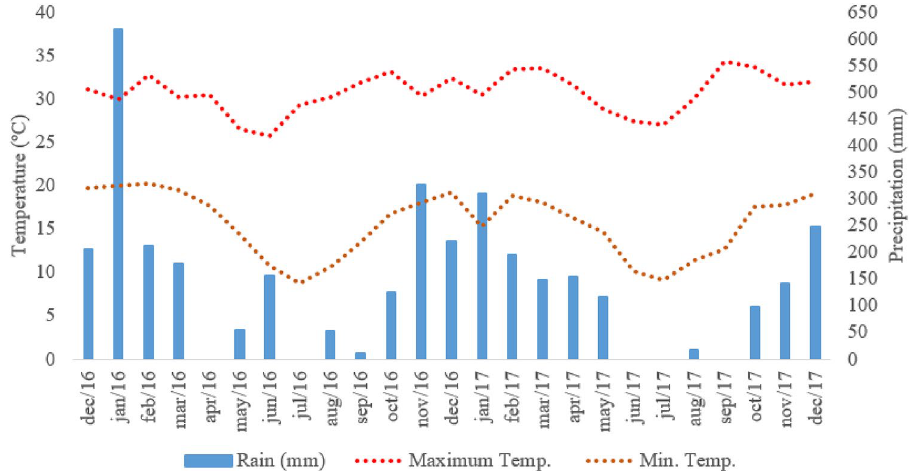
Figure 1. Meteorological data during the study period, obtained from the meteorological station located at Centro de Pesquisa de Bovinos de Corte, Instituto de Zootecnia/Agência Paulista de Tecnologia dos